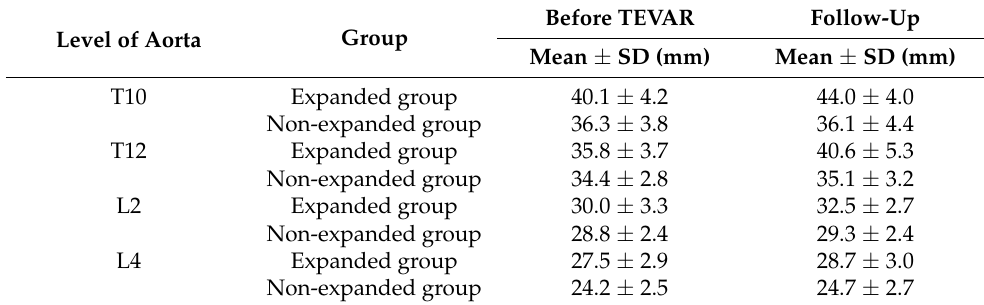
Table 3. Changes in aortic diameter at four levels after TEVAR.